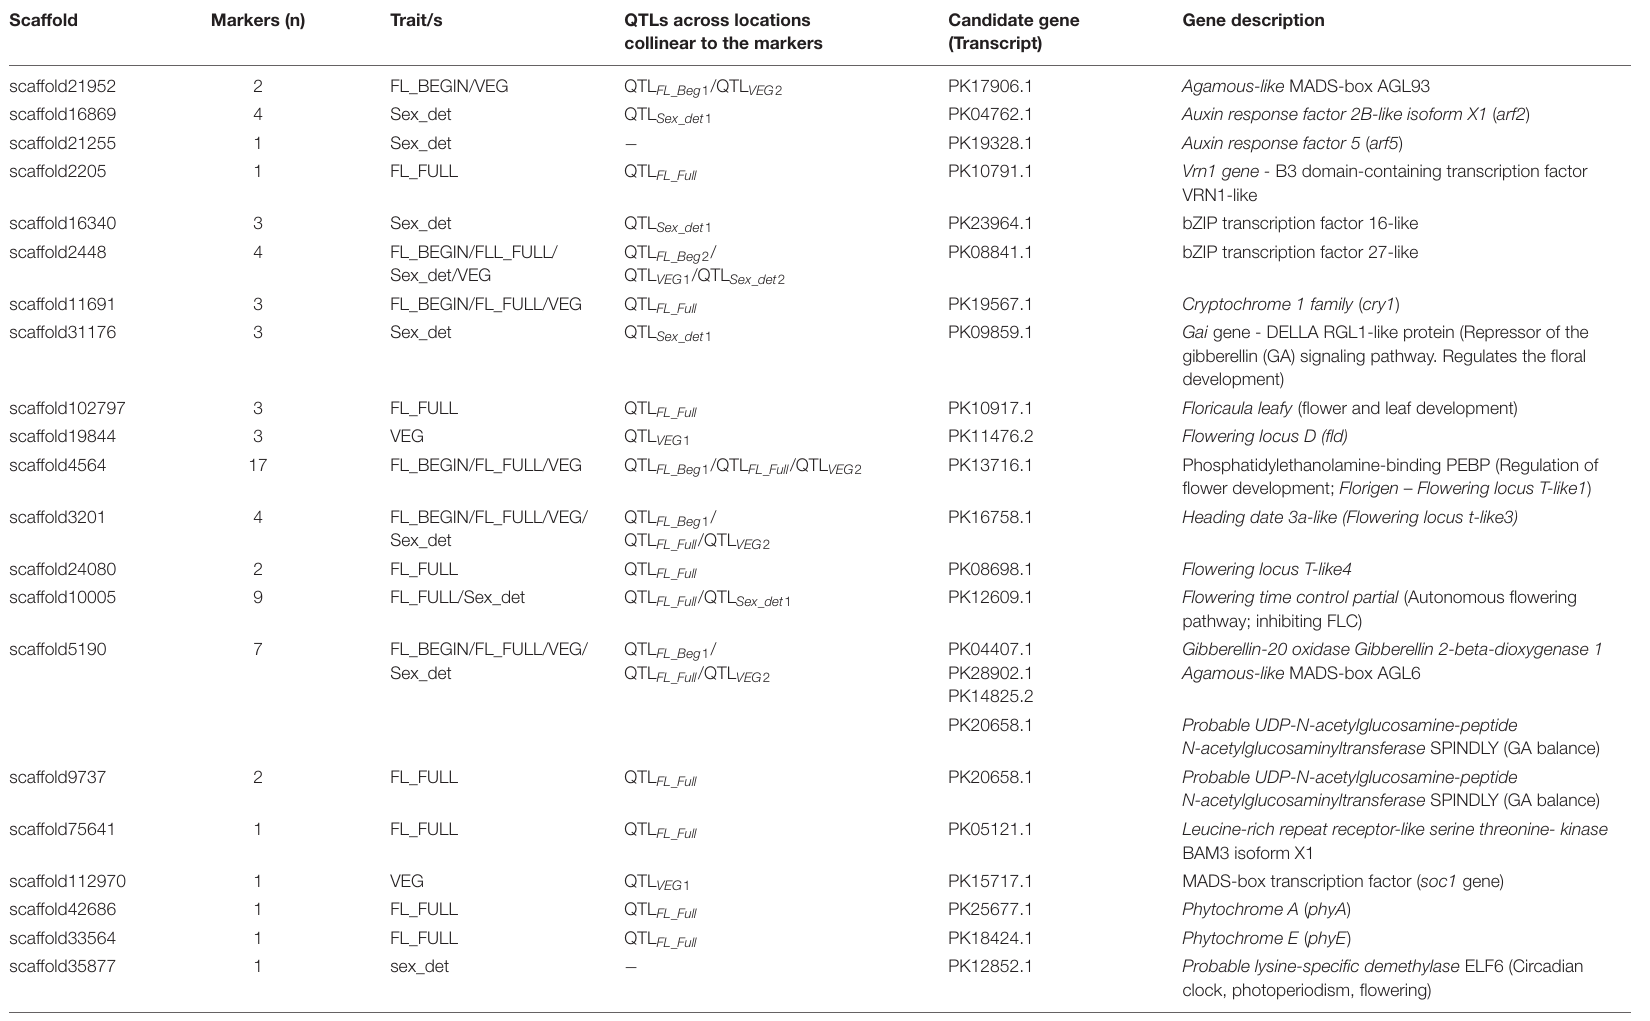
TABLE 4 | Candidate genes in QTL regions across locations. Scaffold Markers (n) Trait/s QTLs across locations